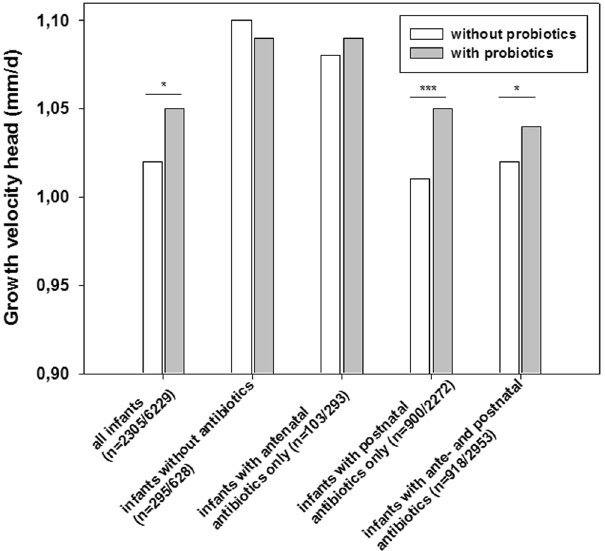
Figure 2. The effect of probiotics and modification by antibiotics on head circumference. The figure describes the effect of probiotics on growth velocity [difference of birth and discharge measures/number of days (duration of primary stay in hospital)] for head circumference. The effect is modified by exposure to antibiotics, the different strata are depicted on the x-axis. For each stratum, numbers of infants without probiotic treatment/ with probiotic treatment are given. * p < 0.05, ** p < 0.01, *** p < 0.001 (Fisher’s exact test, two-sided).